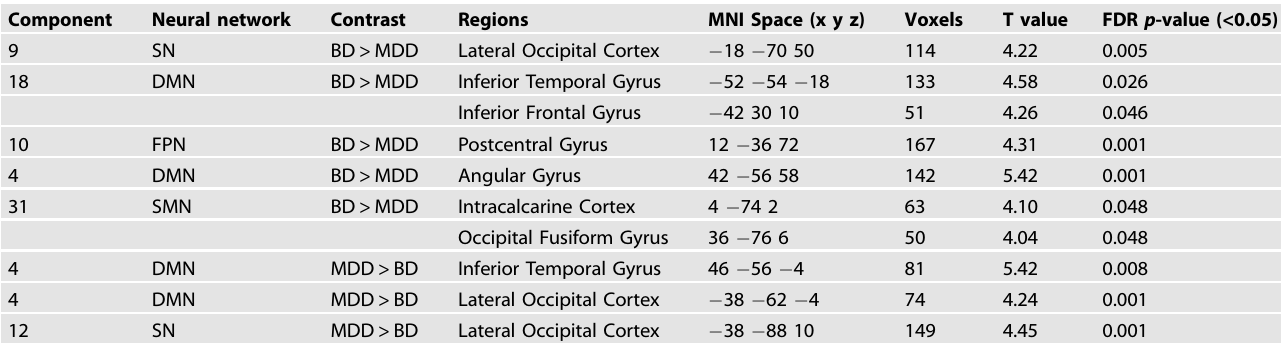
Table 2. Differences in ICA network connectivity between BD &